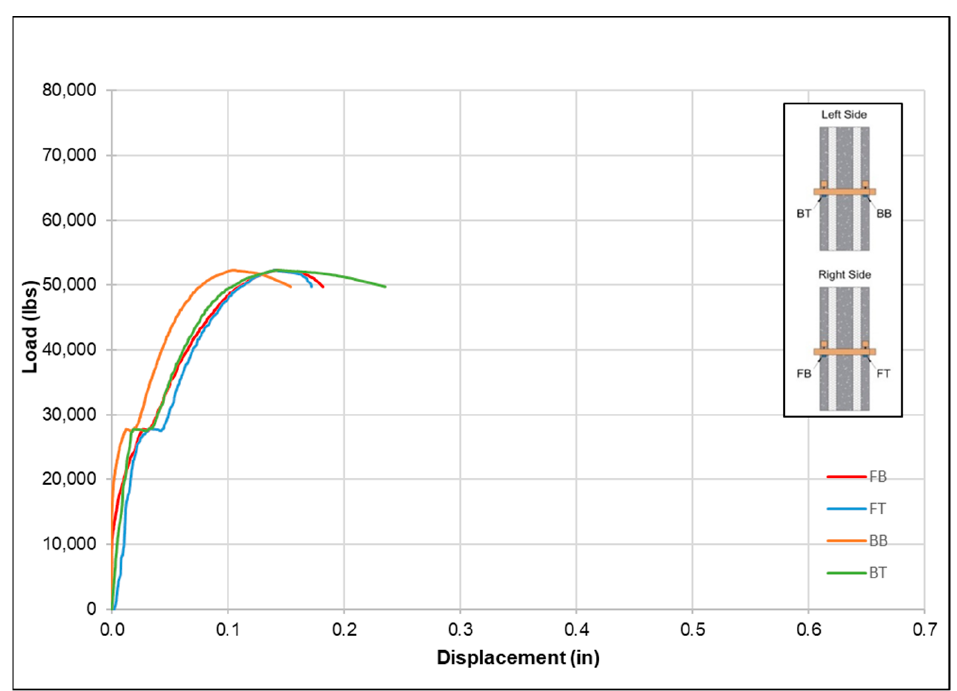
Figure 11. Panels EPS.24.4.MMGRID.1 ( top ), 2 ( middle ), and 3 ( bo tt om ) after testing.